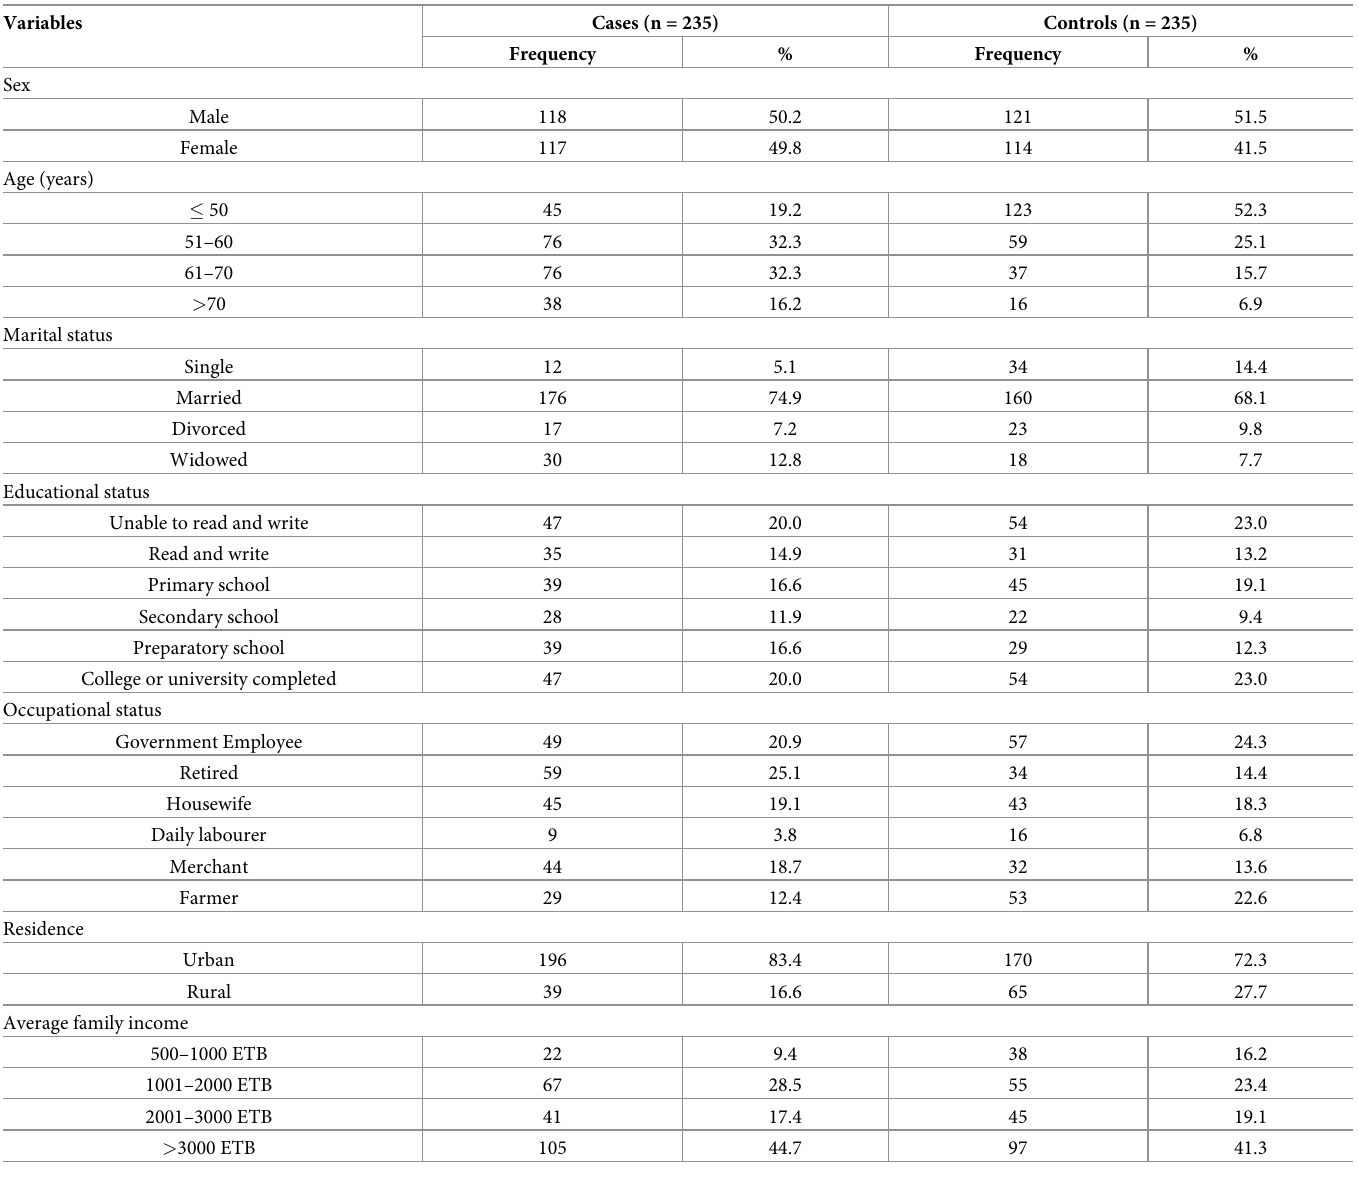
Table 1. Sociodemographic characteristics of study